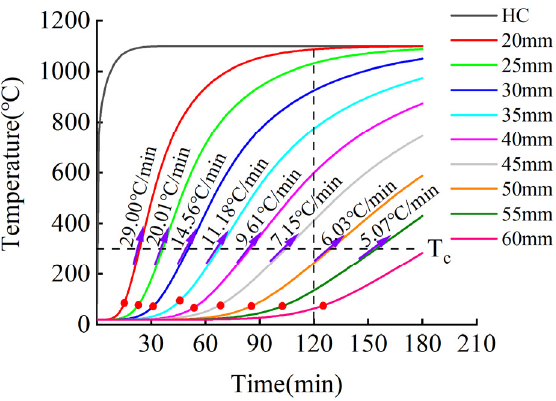
Figure 20. Temperature ‐ time curve of CFRP tendons protected with ceramic fiber felt.